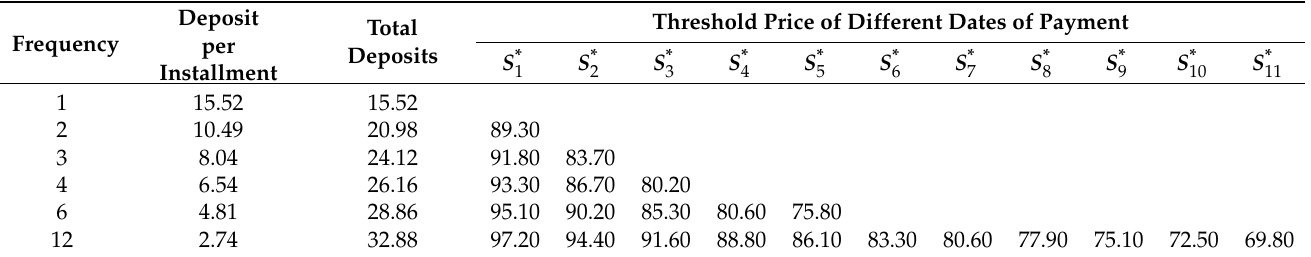
Table 2. Fair Deposits under Single-, Dual-, and Multi-Installment